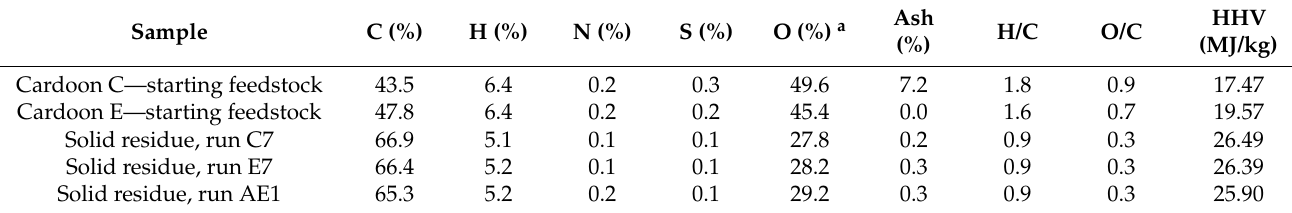
Table 6. Results of the elemental analysis for the starting C and E dry cardoon samples, for the solid residues at the end of runs C7 and E7 (hydrolysis reactions) and for the solid residue at the end of run AE1 (alcoholysis reaction). Sample C